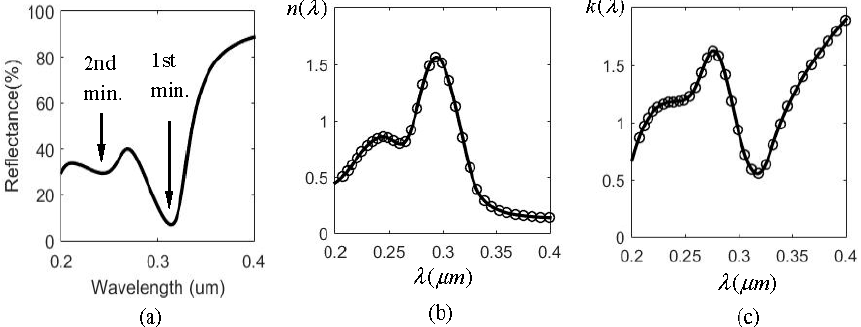
Figure 3. ( a ) Ag reflectance in the ultraviolet region (0.2–0.4 µm); ( b ) The refraction index n of Ag versus wavelength; ( c ) The extinction coefficient k of Ag versus wavelength [16].